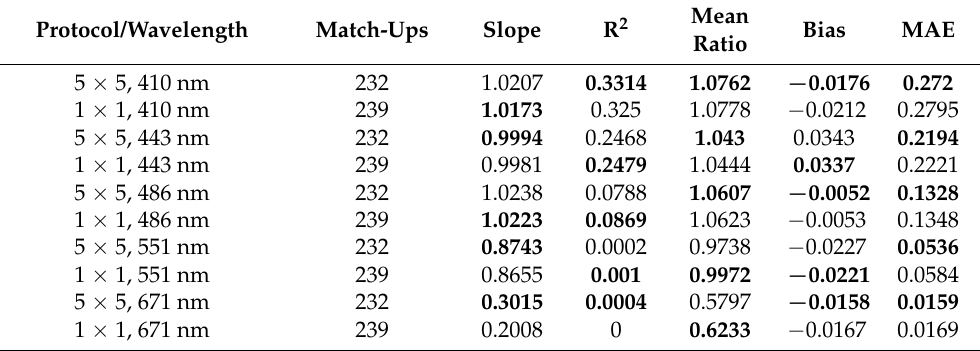
Figure 9. MOBY–VIIRS comparison, June 2014–May 2019. Permissive protocol, ( a ) 5 × 5 statistical box, ( b ) center (in situ) pixel, and ( c ) strict protocol. Slightly more than 70% reduction in match-ups from the permissive protocol. Strict 1 × 1 is not presented as the differences are in many cases a few tenths of a percent. Table 8. MOBY data, June 2014–May 2019. Permissive data protocol at 5 × 5 and 1 × 1 box sizes. Values closest to one in bold, for slope, R 2 , and mean ratio. Lowest values in bold for bias and mean absolute